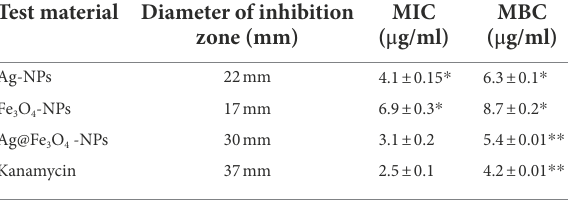
TABLE 2 The diameter of zone inhibition (mm), MIC value (mg/ml), and MBC value ( μ g/ml) for Salmonella typhimurium. Test material Diameter of inhibition zone